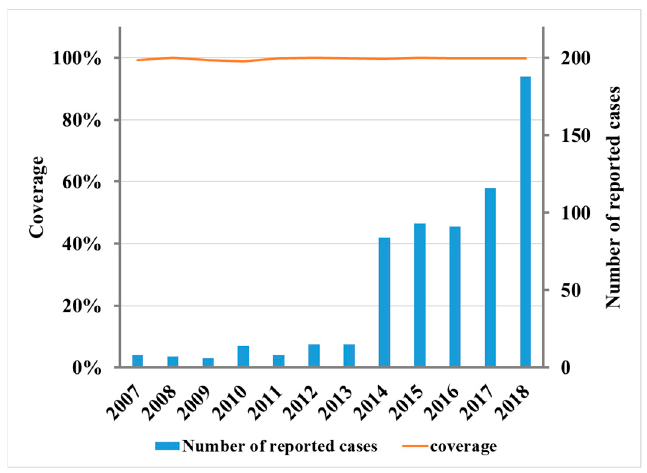
Figure A1. DTP vaccination coverage and number of reported pertussis cases in Beijing, 2011~2018 [12,20]. Based on the public data available from Beijing Municipal Health Big Data and Policy Research Center and The Data-center of China Public Health Science.